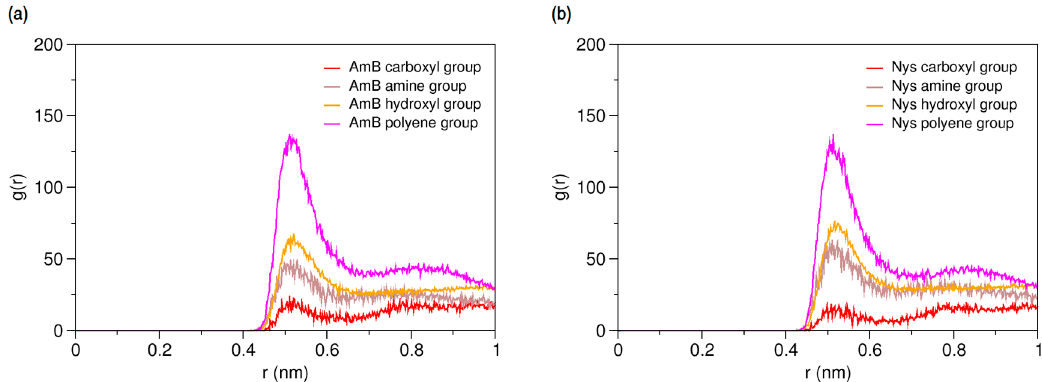
Figure 6. Average radial pair distribution functions for various moieties of ( a ) AmB; and ( b ) Nys against single P80 molecule in aqueous medium.